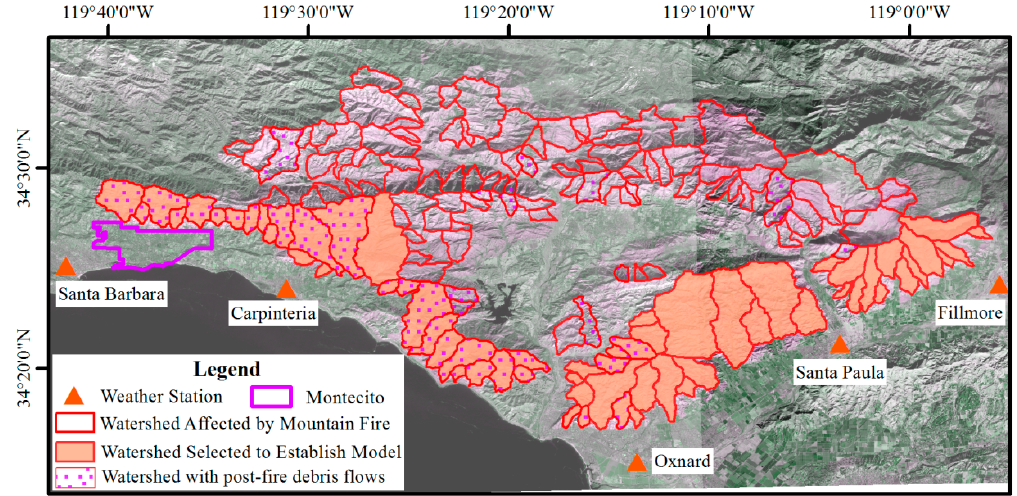
Figure 9. Watersheds selected to establish the prediction model to analyze the occurrence probability of post-fire debris flows.